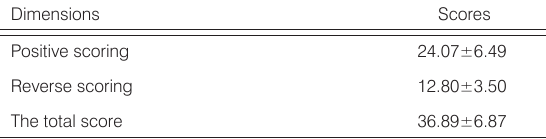
Table 3. Scores of anxiety self-rating scale in obstetric nurses (mean±SD).